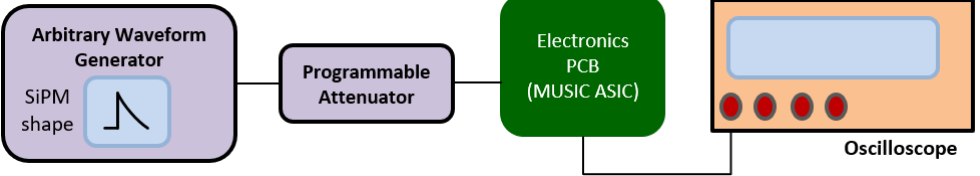
Figure 8. Schematic representation of the experimental setup used to evaluate the linearity of the energy measurement. The electronics are placed in a light tight